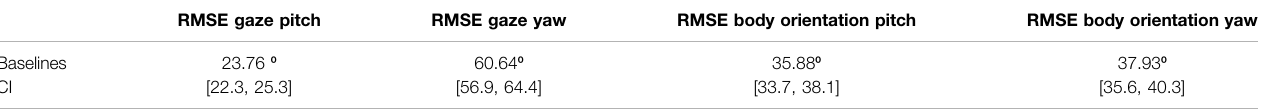
TABLE 2| AverageoftheRMSE(indegrees) ofthebaselines forthepitchandyawofthegaze,andthepitchandyawofthebodyorientation,withrespecttotheestimations ofthoseanglesprovidedbytheteachers,andtherespective95%Con fi denceIntervals(CI).Ingeneral,theRMSEofthebaselinesis10degreeshigher thantheRMSEof the teachers.